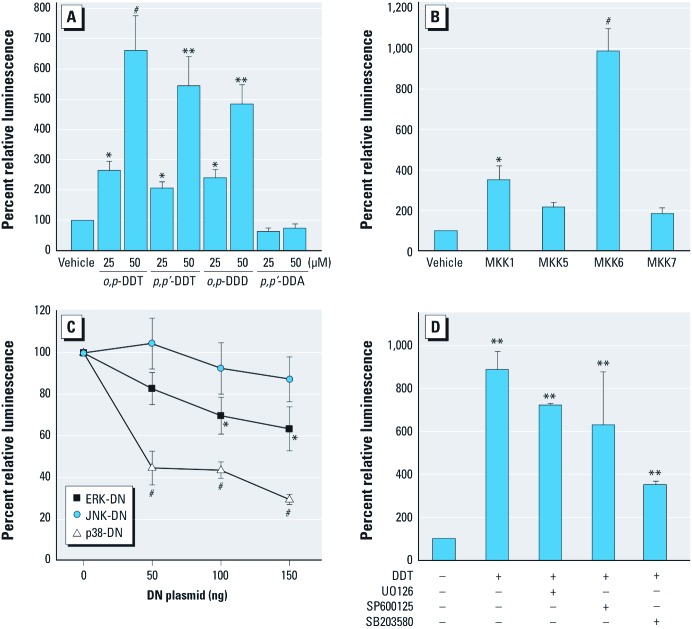
DDT and its metabolites stimulate the coactivator CBP through activation of the p38 MAPK pathway. (A) ER-negative HEK 293 cells transfected with GAL4-CBP and a GAL4-luc reporter and incubated overnight with organochlorines; n = 4. (B) HEK 293 cells transfected overnight with GAL4‑CBP, a GAL4-luc reporter, and either an empty vector or a vector expressing constitutively active MKK1 (ERK1/2), MKK5 (ERK5), MKK6 (p38), or MKK7 (JNK); n = 3. (C) HEK 293 cells transfected with GAL4-CBP, GAL4-luc, and increasing amounts of dominant negative (DN) mutants and then treated with 50 μM o,p’‑DDT for 24 hr; n = 4–6. (D) HEK 293 cells transfected with either empty vector or GAL4-CBP and GAL4-luc; after 6 hr, MAPK inhibitors were added (1 μM UO126, 1 μM SP600125, 6 μM SB203580), followed 1 hr later by 50 μM o,p’‑DDT for 18 hr (n = 4). Values are mean ± SE luciferase activity, with control values set to 100%. *p < 0.05, **p < 0.01, and #p < 0.001, compared with vehicle control (A) or empty vector control (B,C,D).